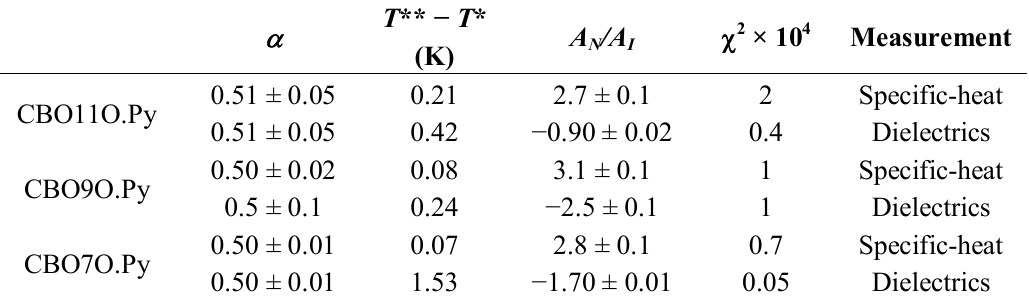
Table 2. Fitting parameters from the specific-heat and dielectric